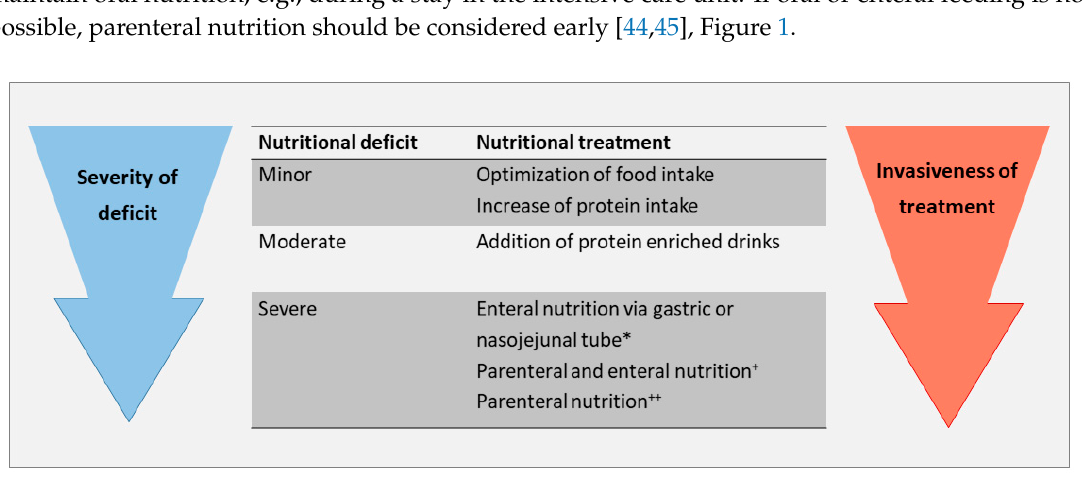
Figure 1. Nutrition management in malnourished patients with liver cirrhosis. * Non-bleeding esophageal varices are not a contraindication for enteral tube feeding, + if enteral nutrition is insufficient, ++ if enteral nutrition is not possible.